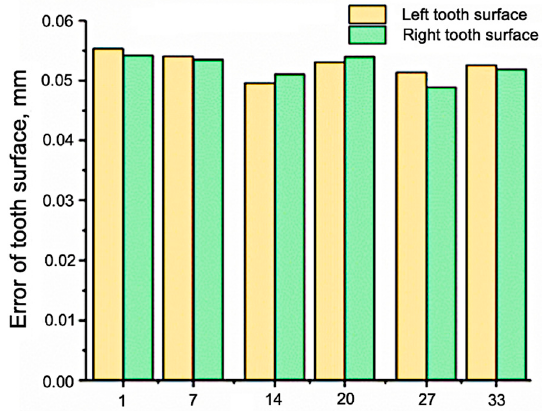
Figure 18. Errors of the tooth surface in the hobbing method [25].